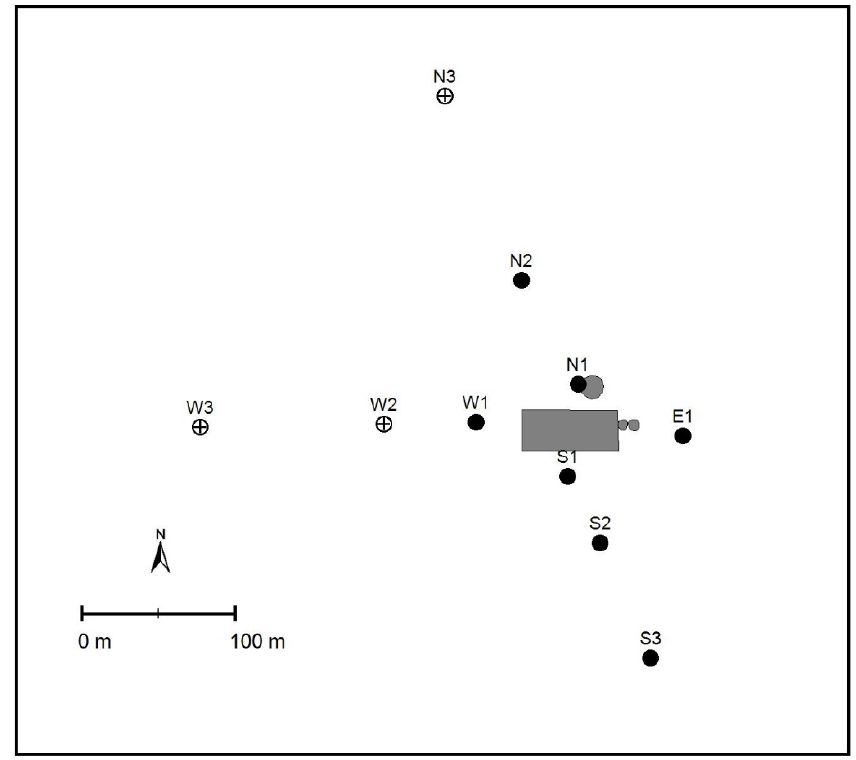
Figure 2. Sitemap of the monitoring sites for ammonia, the fattening piggery including two silos at the east side of the building, and the closed slurry pit north of the livestock building. The modelling domain is marked by the grey rectangle.